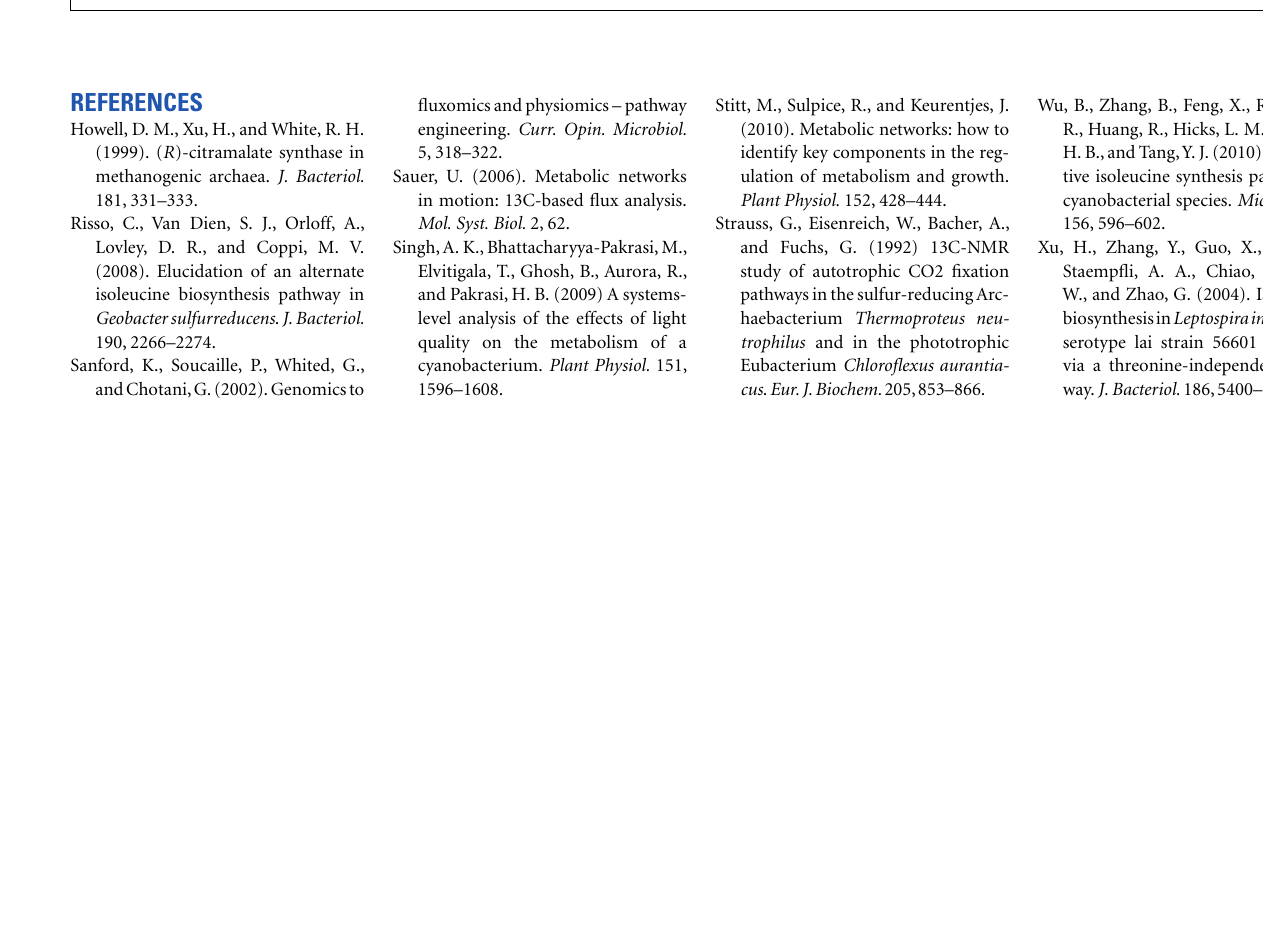
FIGUREA2 |Amino acids biosynthesis in phototrophic and non-phototrophic bacteria. Biosynthesis of amino acids directly and indirectly employing pyruvate and oxaloacetate (OAA) as precursors is shown.